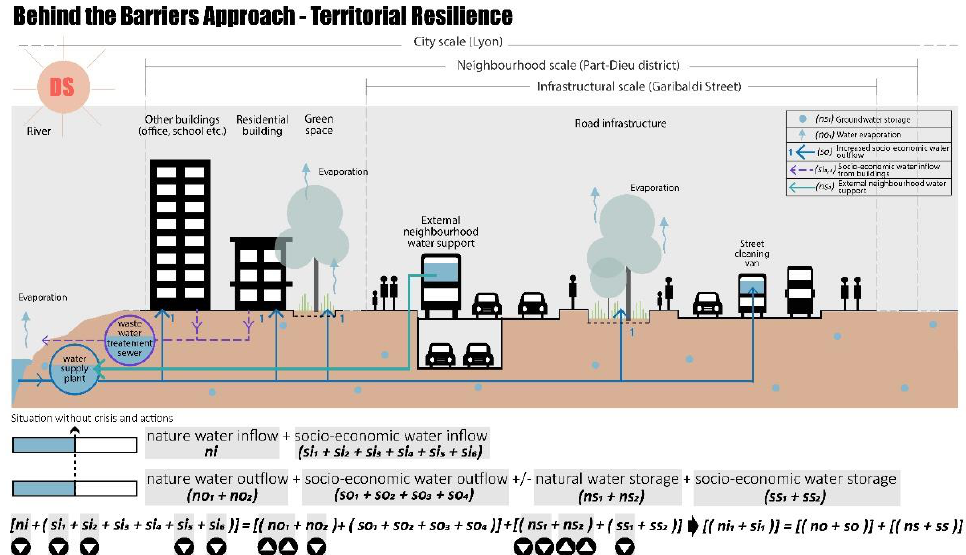
Figure 11. Behind the “barrier”, territorial resilience drought scenario, realised by authors .